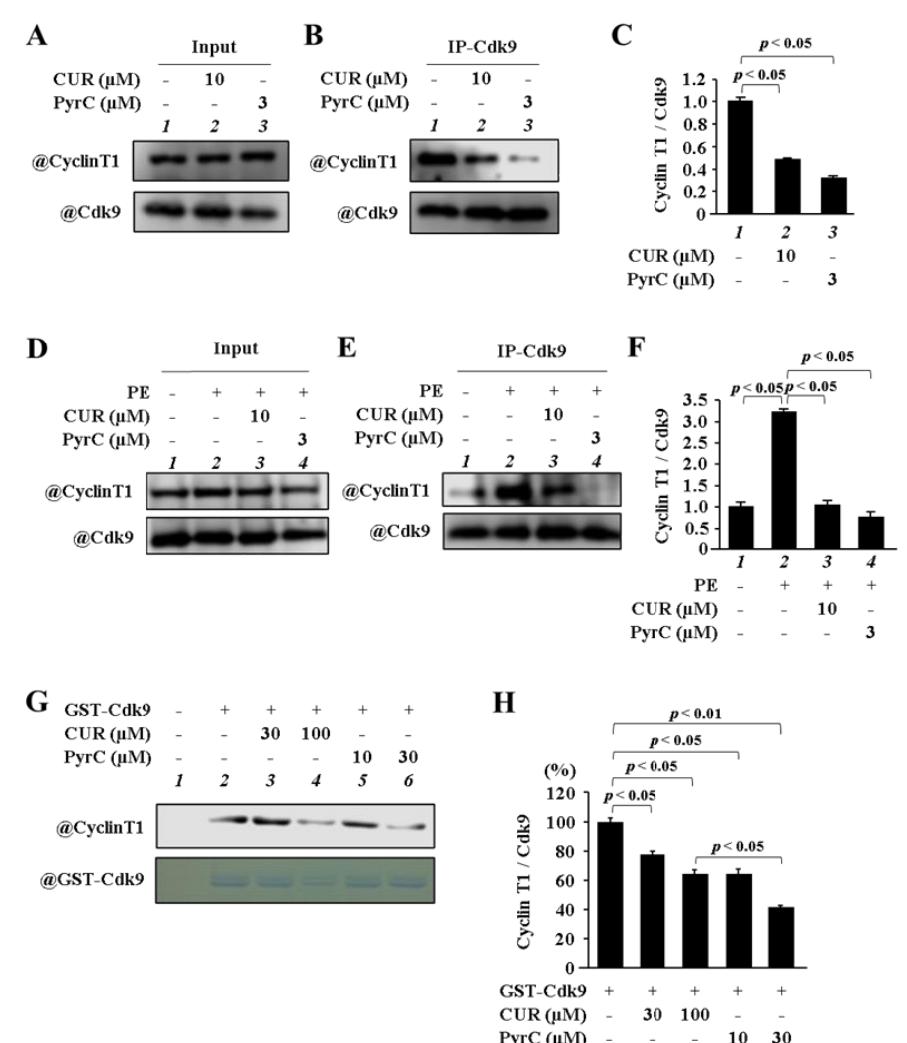
Figure 5. PyrC and CUR reduced the formation of Cyclin T1/Cdk9. ( A – C ) Primary cultured cardiomyocytes were treated with CUR (10 µ M) or PyrC (3 µ M). ( B ) Photograph of a representative IP-WB. ( C ) Quantifications of ( B ). N = 3. ( D , E ) Primary cultured cardiomyocytes were treated with CUR (10 µ M) or PyrC (3 µ M) and stimulated with 30 µ M of PE. ( E ) Photograph of a representative IP-WB. ( F ) Quantifications of ( E ). N = 3. ( G , H ) GST pull-down assay was performed using recombinant 6XHis-cyclin T1 and GST-cdk9. ( G ) Photograph of a representative IP-WB. ( H ) Quantifications of ( G ). N = 3.